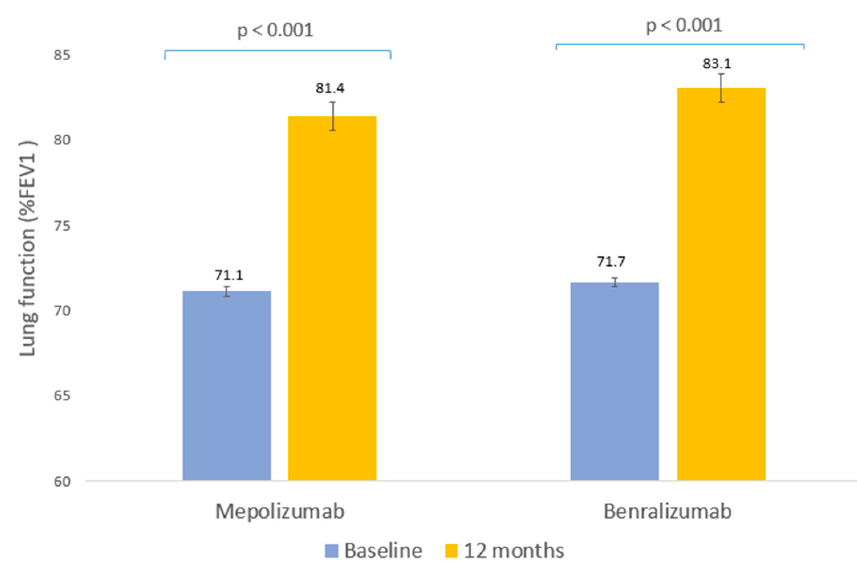
Figure 2. Clinical response to biological therapies: lung function. Mean percentage of peak forced expiratory volume in the first second of forced exhalation (FEV1) prior to biological therapy and after 12 months of therapy.